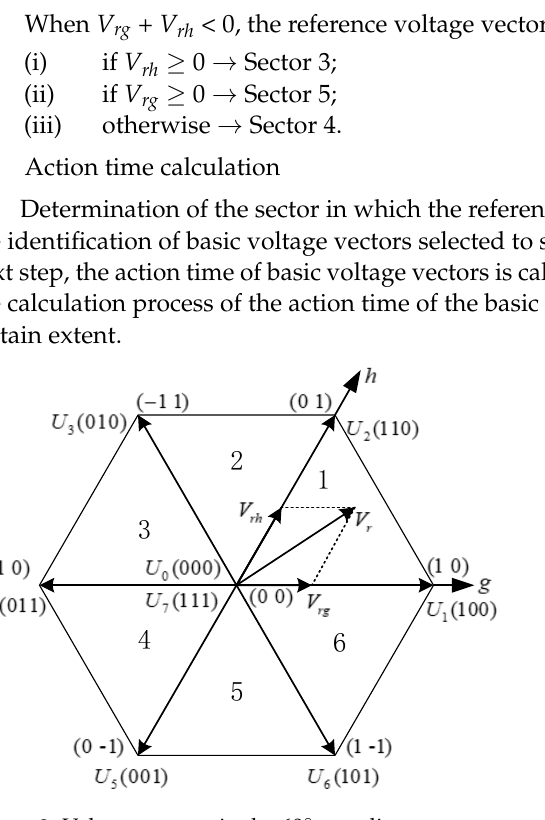
Figure 3. Voltage vectors in the 60° coordinate system.